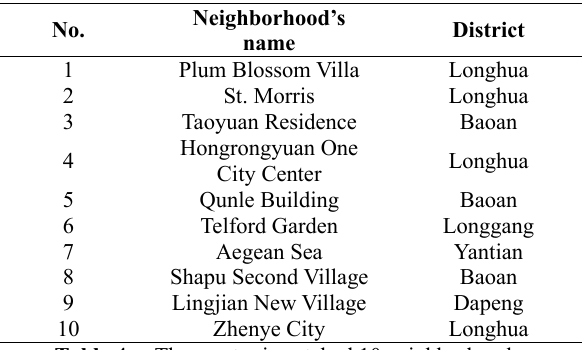
Table 4. The most mismatched 10 neighborhoods